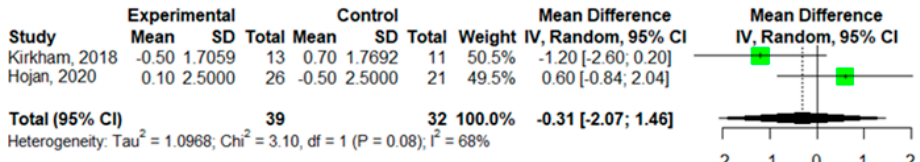
Figure 4. Forest plot showing the effect of exercise intervention compared to control on longitudinal strain.